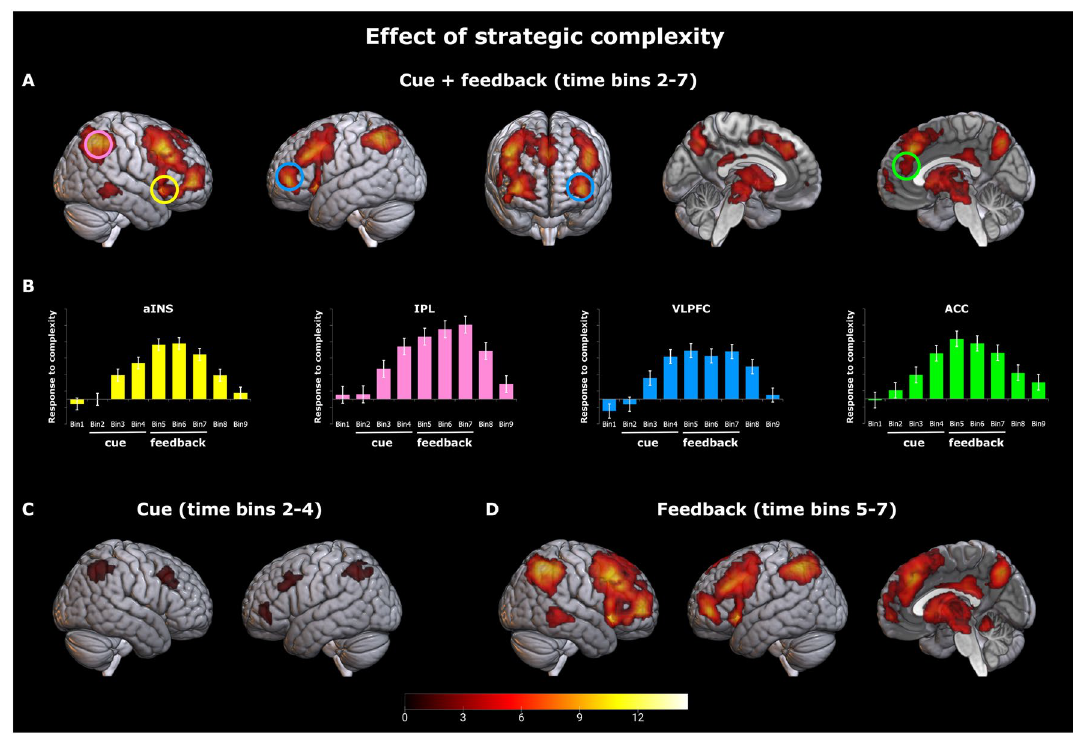
Figure 5. Effect of strategic complexity. Brain areas where neural activation correlated with strategic complexity during both cue and feedback phases ( A ), or only upon cue ( C ), or feedback ( D ) presentation. Modulation of the neural response produced by variation in strategic complexity ( B ). The relation between neural response and complexity is displayed over time in four example peaks in the anterior insula (first graph from left), inferior parietal lobule (second graph), ventrolateral prefrontal cortex (third graph), and anterior cingulate cortex (fourth graph). The x-axis of the bar-plots shows the time bins, each lasting 2 s. The time bins likely corresponding to the cue and feedback phases are highlighted. The y-axis shows the intensity of the modulation of the neural response produced by the strategic complexity, that is, the average coefficient of regression of complexity. In ( A ), the position of the example peaks is circled (with a color matching the corresponding graph). Error bars represent SEM. Intensities in ( A , C , D ) are color-coded according to the color bar displayed at the bottom, representing the correspondence between t -values and colors. We used a threshold of 0.001 at the voxel level and of 0.05 at the cluster level, FWE-corrected for multiple comparisons. aINS: anterior insula, IPL: inferior parietal lobule, VLPFC: ventrolateral prefrontal cortex, ACC: anterior cingulate